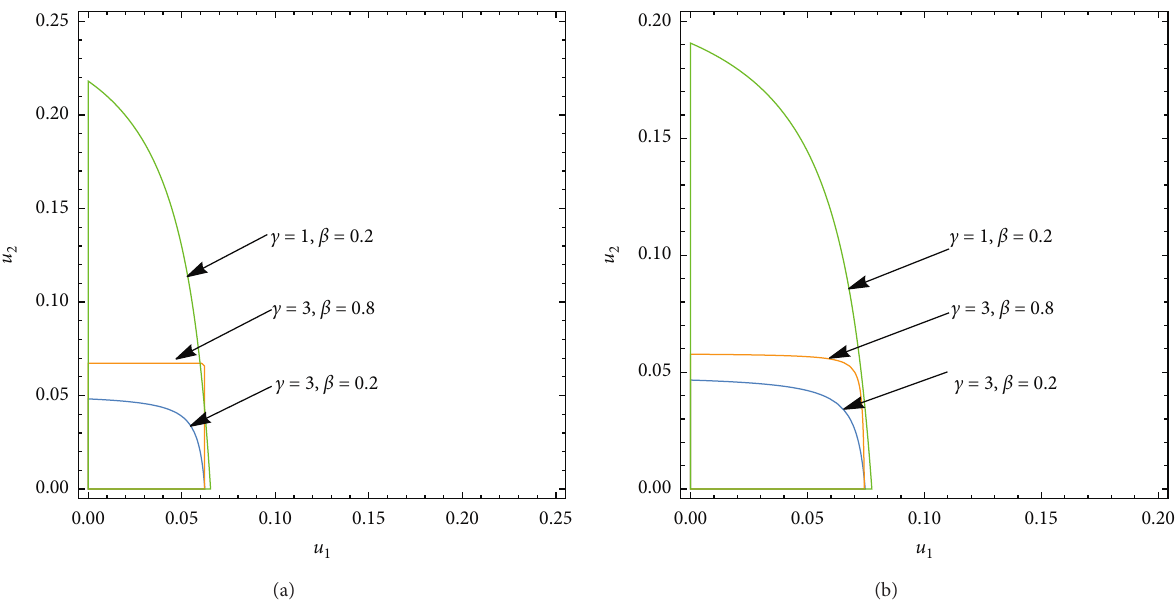
Figure 3: The influence of parameters on the stability region of the system. (a) nl system. (b) m